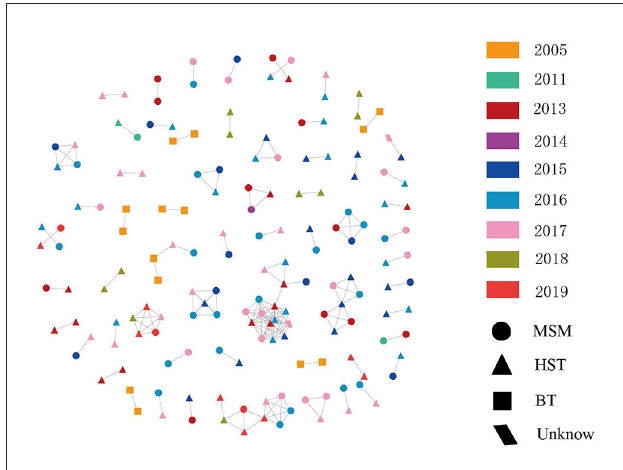
FIGURE3 Fuyang City HIV-1 surveillance molecular transmission network. Links (i.e., edges) indicate genetic distance ≤ 0.015 substitutions/site. Color indicates diagnosed time. Shape indicated transmission route. HST, heterosexual; MSM, men who have sex with men; BT, blood transmission